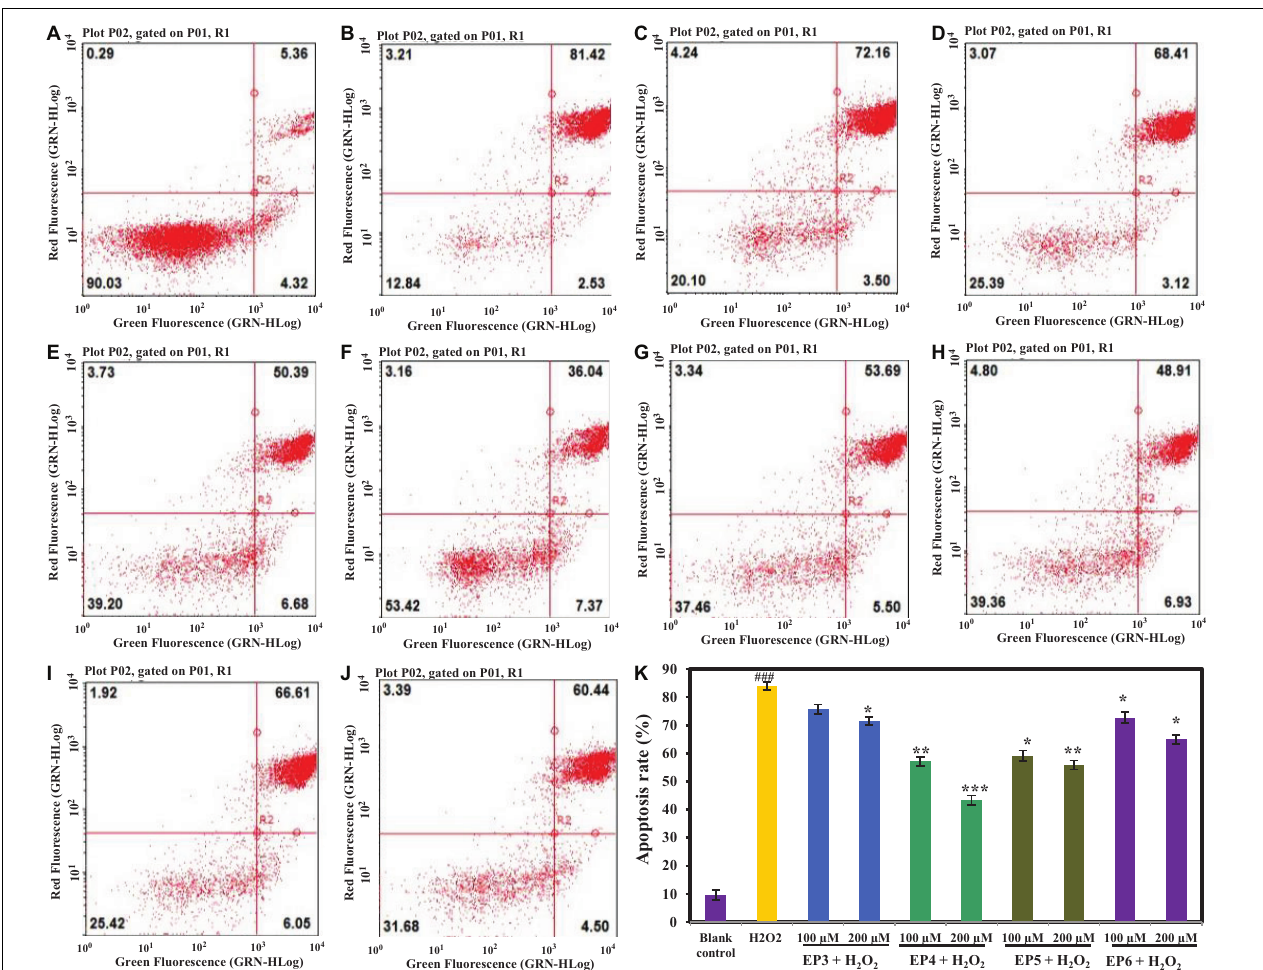
FIGURE 8 | Effects of the antioxidant peptides (EP3–EP6) on HUVEC apoptosis determined by annexin V and propidine iodide (AV-PI) staining. In the Figure 8A–J , the left upper quadrant (LU) represents necrotic cells (annexin-/PI +), the left lower quadrant (LL) represents normal living cells (annexin-/PI-), the right lower quadrant (RL) represents the early apoptotic cells (annexin + /PI-) and the right upper quadrant (RU) represents late apoptotic cells (annexin + /PI +). (A) Blank control refers to normal cells without any treatment; (B) H 2 O 2 -induced model (300 µ m for 6 h); (C) EP3 (100 µ m) + H 2 O 2 (300 µ m for 6 h); (D) EP3 (200 µ m) + H 2 O 2 (300 µ m for 6 h); (E) EP4 (100 µ m) + H 2 O 2 (300 µ m for 6 h); (F) EP4 (200 µ m) + H 2 O 2 (300 µ m for 6 h); (G) EP5 (100 µ m) + H 2 O 2 (300 µ m for 6 h); (H) EP5 (200 µ m) + H 2 O 2 (300 µ m for 6 h); (I) EP6 (100 µ m) + H 2 O 2 (300 µ m for 6 h); (J) EP6 (200 µ m) + H 2 O 2 (300 µ m for 6 h); (K) the apoptosis rates of HUVECs when the concentrations of blank control, H 2 O 2 -induced model group, 100 µ m and 200 µ m EP3–EP6 + H 2 O 2 (300 µ m for 6 h) ( ### p < 0.001 vs. blank control group; ∗∗∗ p < 0.001, ∗∗ p < 0.01, ∗ p < 0.05 vs. H 2 O 2 -induced model group).